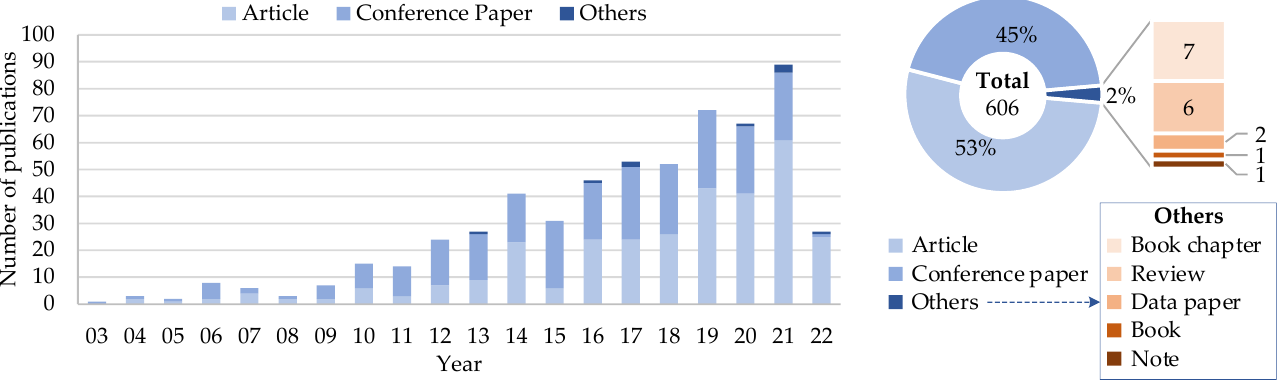
Figure 3. Number of publications related to wind power and speed forecasting. Temporal evolution of publications by type from 2003 to 2022, and percentage according to type of publication.